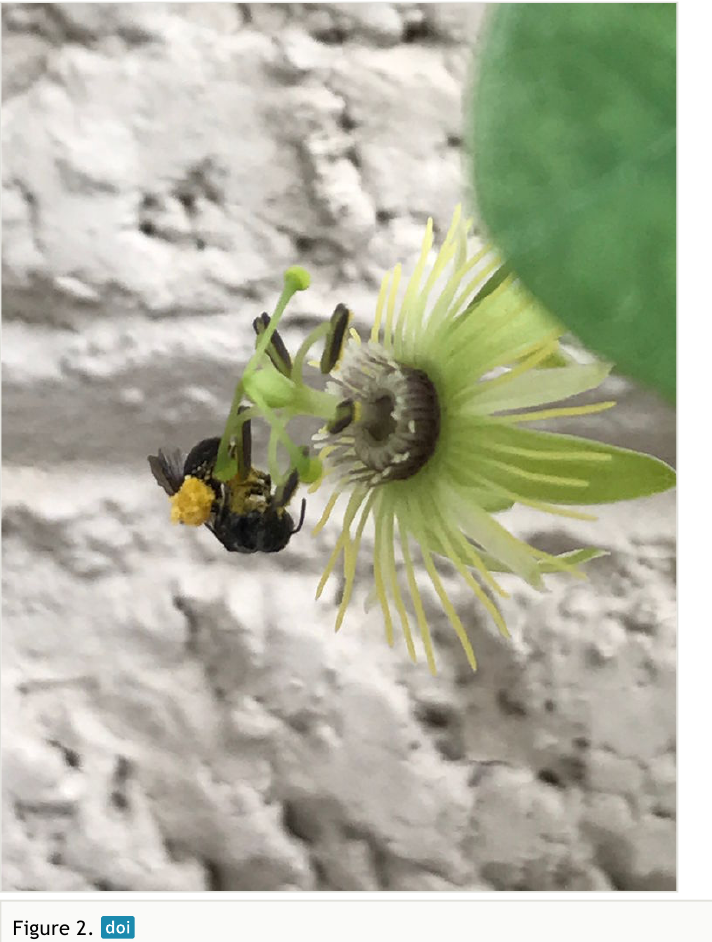
Female A. passi fl orae observed on P. lutea in Bolivar County,